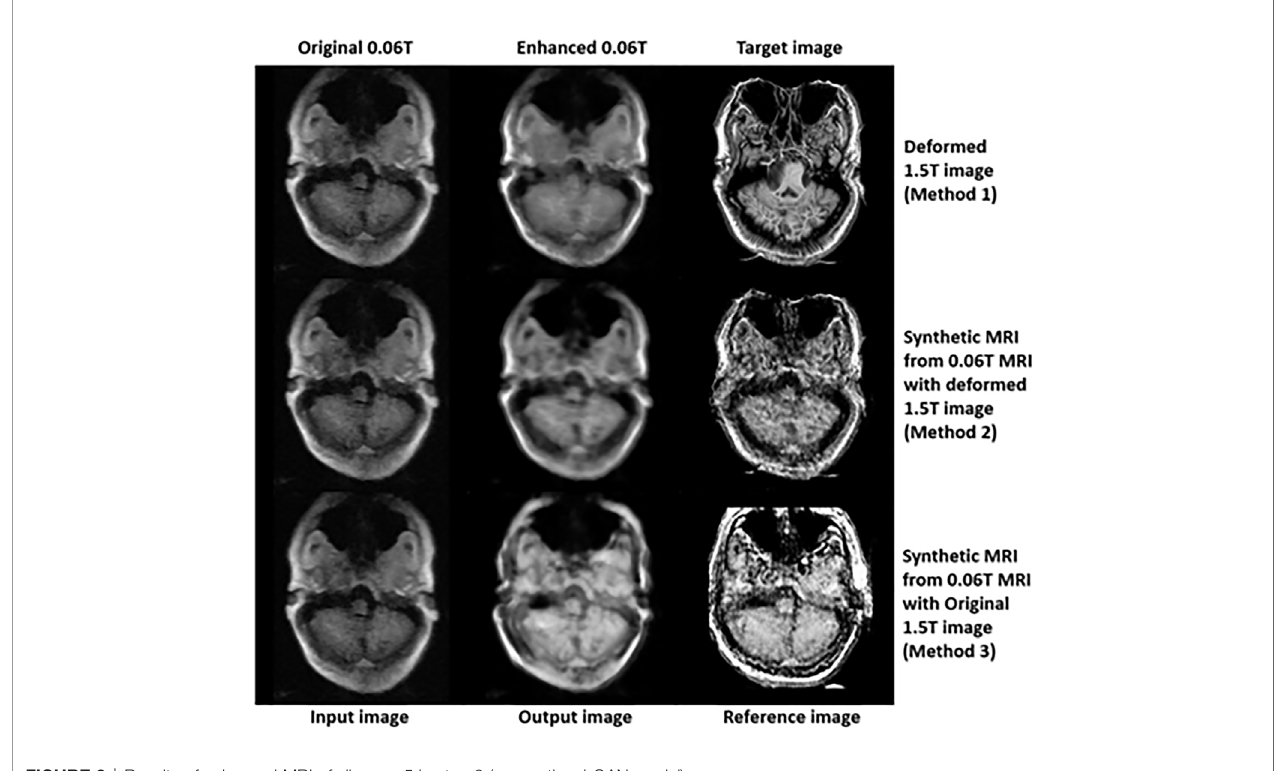
FIGURE 8 | Results of enhanced MRI of slice no. 5 in step 3 (conventional-GAN model).